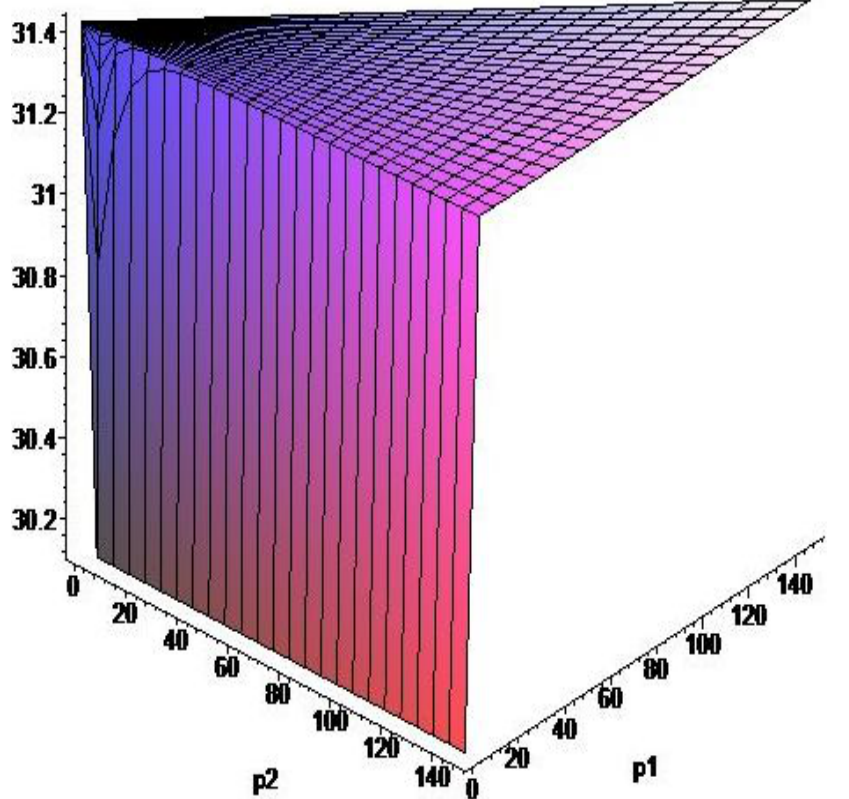
Figure 8. Surface (cid:101) J ( θ ) for the Ebola outbreak in Uganda (2000) for σ = 10 , ν = 10 .